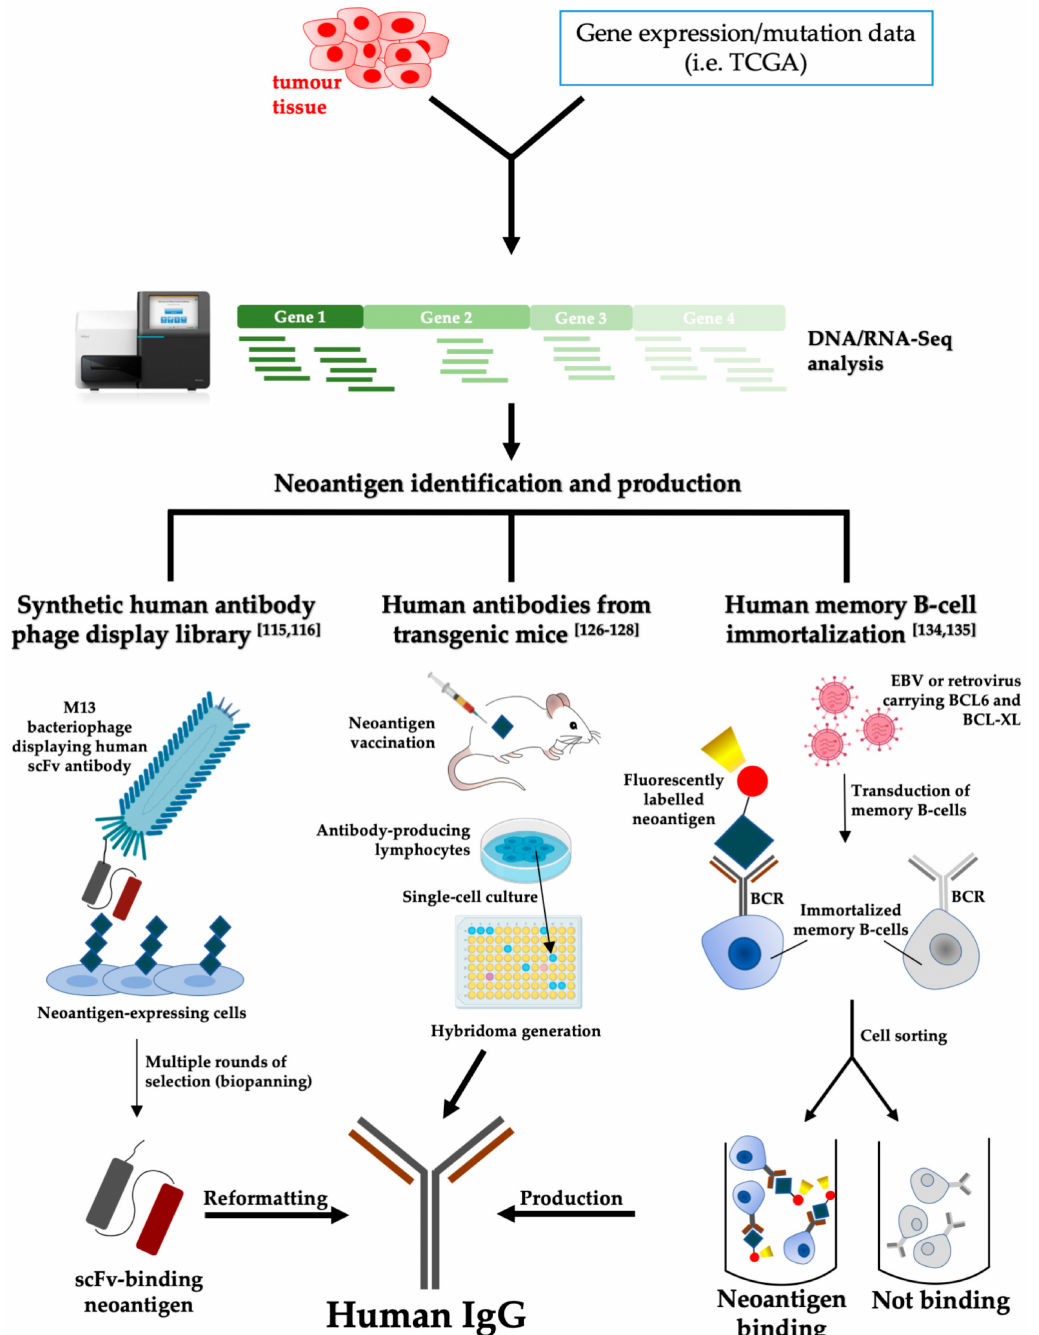
Figure 1. Schematic representation of antigen-based screening strategies to obtain fully human tumor-targeting